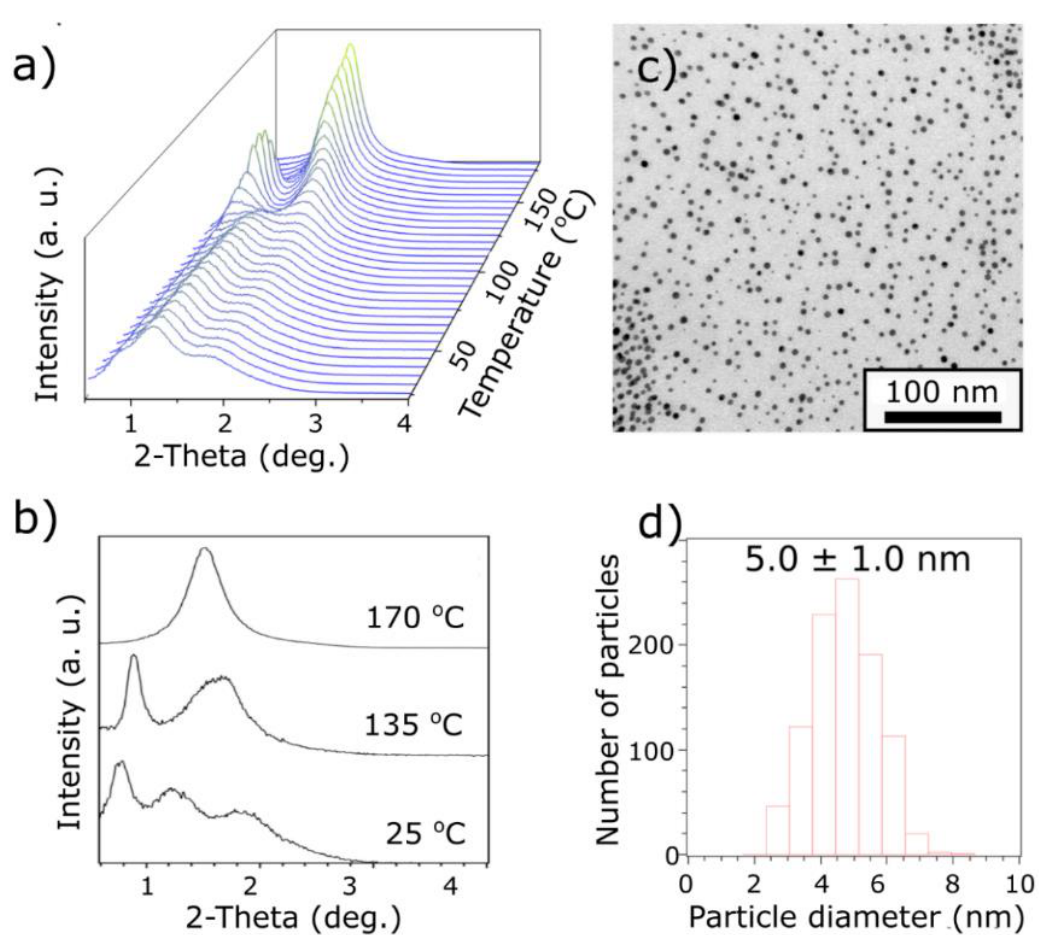
Figure 4. SAXRD and TEM analysis of 5-L M L A material. ( a ) Temperature evolution of SAXRD peaks during heating; ( b ) comparison of XRD peak location at temperatures of 25 ◦ C, 135 ◦ C, and 170 ◦ C as obtained by integration of suitable patterns; ( c ) TEM image of material; ( d ) histogram of size distribution of 5-L M L A nanoparticles